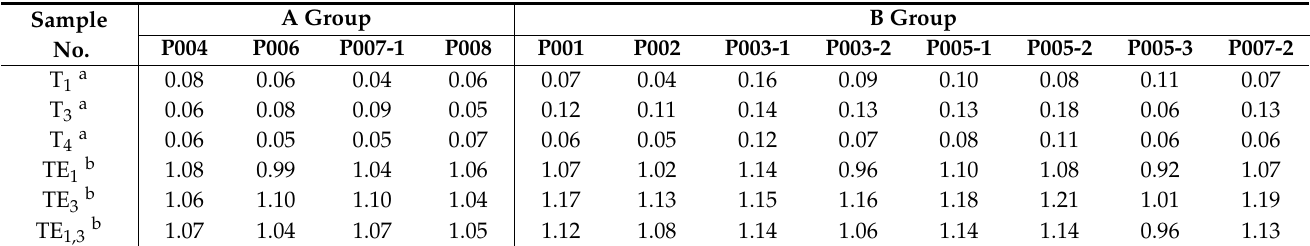
Table 2. Calculated tetrad effect and geochemical parameters for Pirrit Hills granite